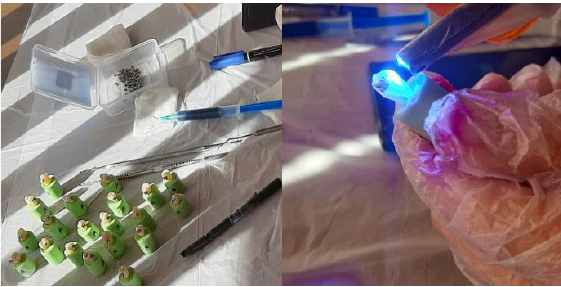
Figure 1. Bonding of the bracket to the enamel surface.